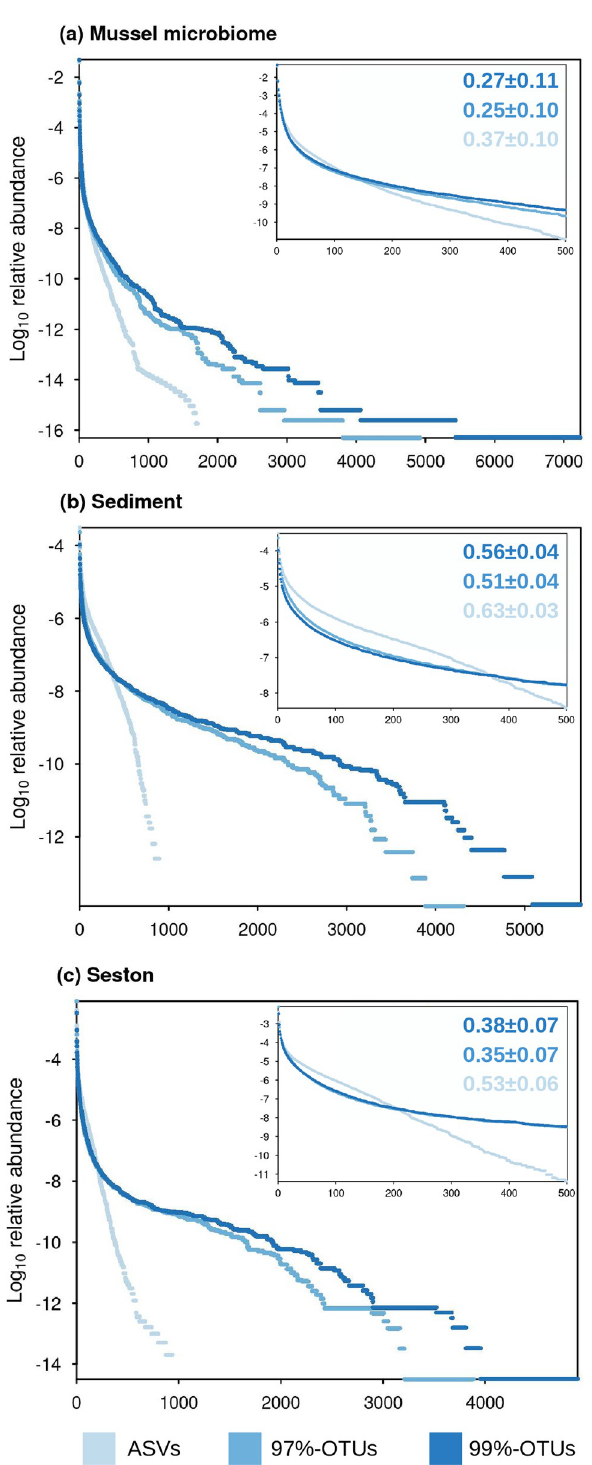
Fig 1. Effect of sequence processing methodology on the rank abundance of operational units. The relative abundance of ASVs (obtained from DADA2) and OTUs defined by 97% or 99% identity (obtained from MOTHUR). Units were sorted according to their rank of abundance and represented separately for each community type (a: mussel gut microbiome, b: sediment, c: seston). Inserts focus on the 500 most abundant operational units. The evenness of the relative abundance of the operational units computed Bulla’s O are displayed on each